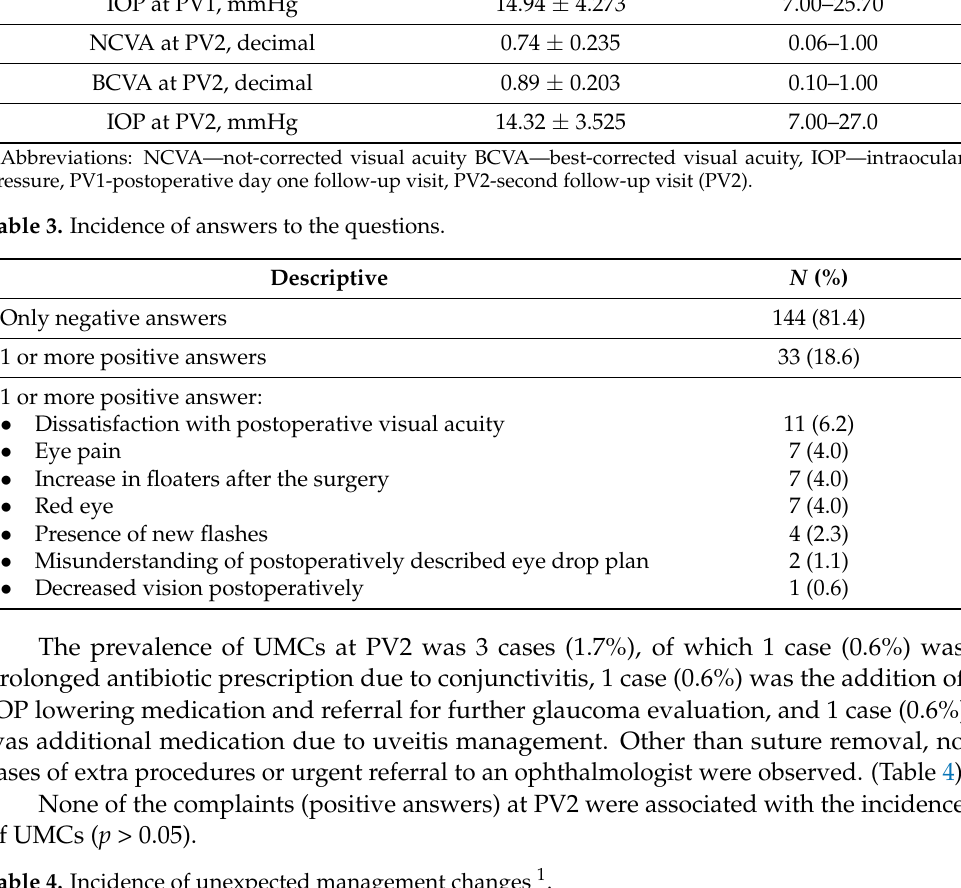
Table 4. Incidence of unexpected management changes 1